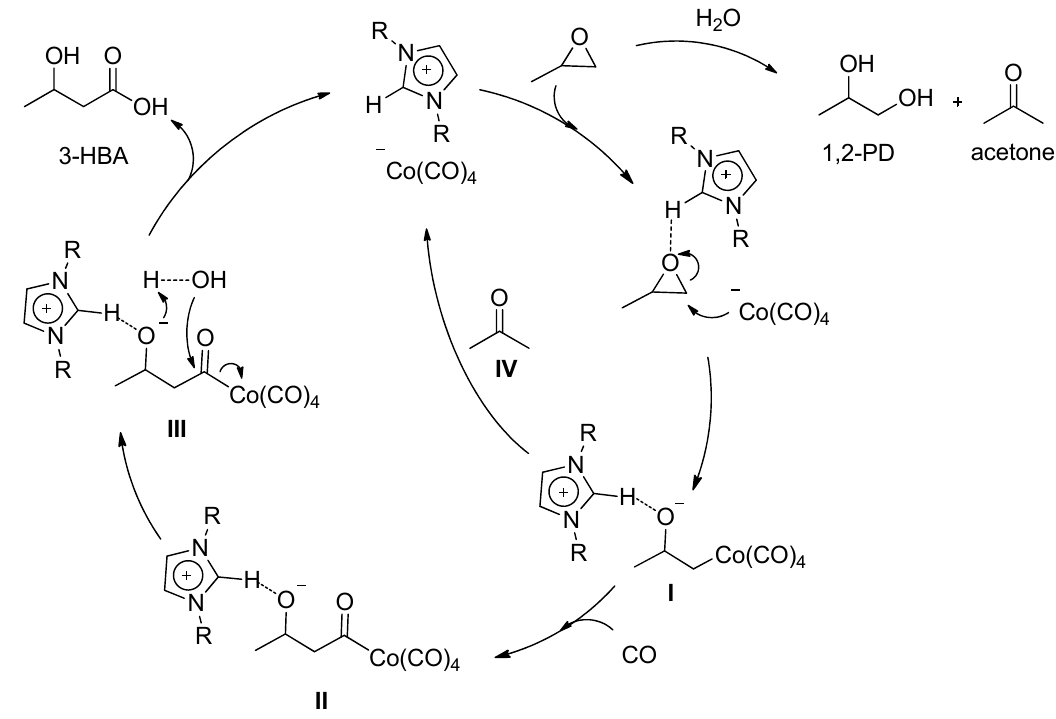
Figure 1. Proposed mechanism for the formation of 3 ‐ HBA and side products (1,2 ‐ PD and acetone).